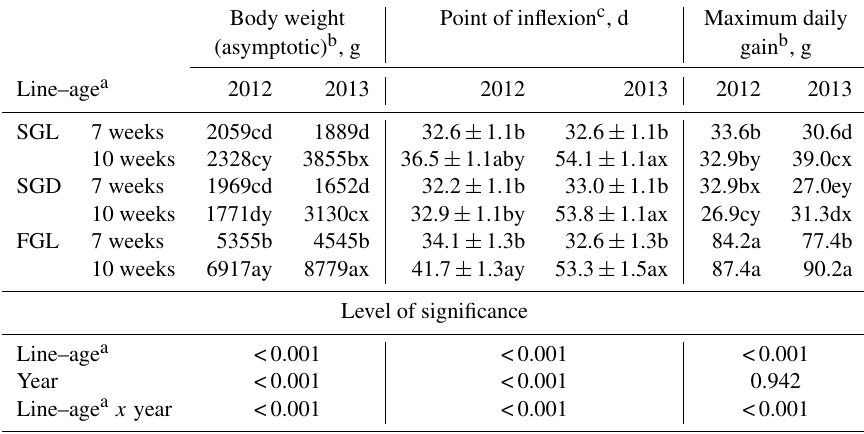
Table 5. Effect of the combination of chicken line, slaughter age, and year on Gompertz–Laird growth curve parameters. Body weight